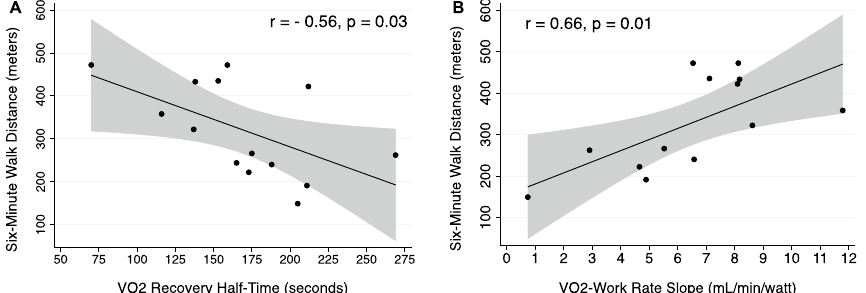
Fig. 3 Correlation plots of oxygen utilization measures and 6-min walk test. Measures of oxygen utilization during exercise and in recovery in CPET are strongly associated with distance walked (m) during 6-min walk test. A and B Demonstrate correlations between 6-min walk distance and VO 2 -work rate slope and with VO 2 recovery t 1/2 . All correlations calculated using Pearson’s correlation